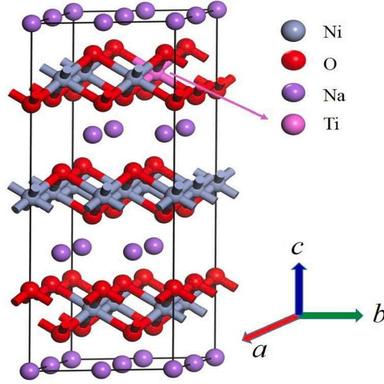
Schematic illustration of the 2✕2✕1 supercell of Ti-doped NaNiO2, Na12Ni11Ti1O24.